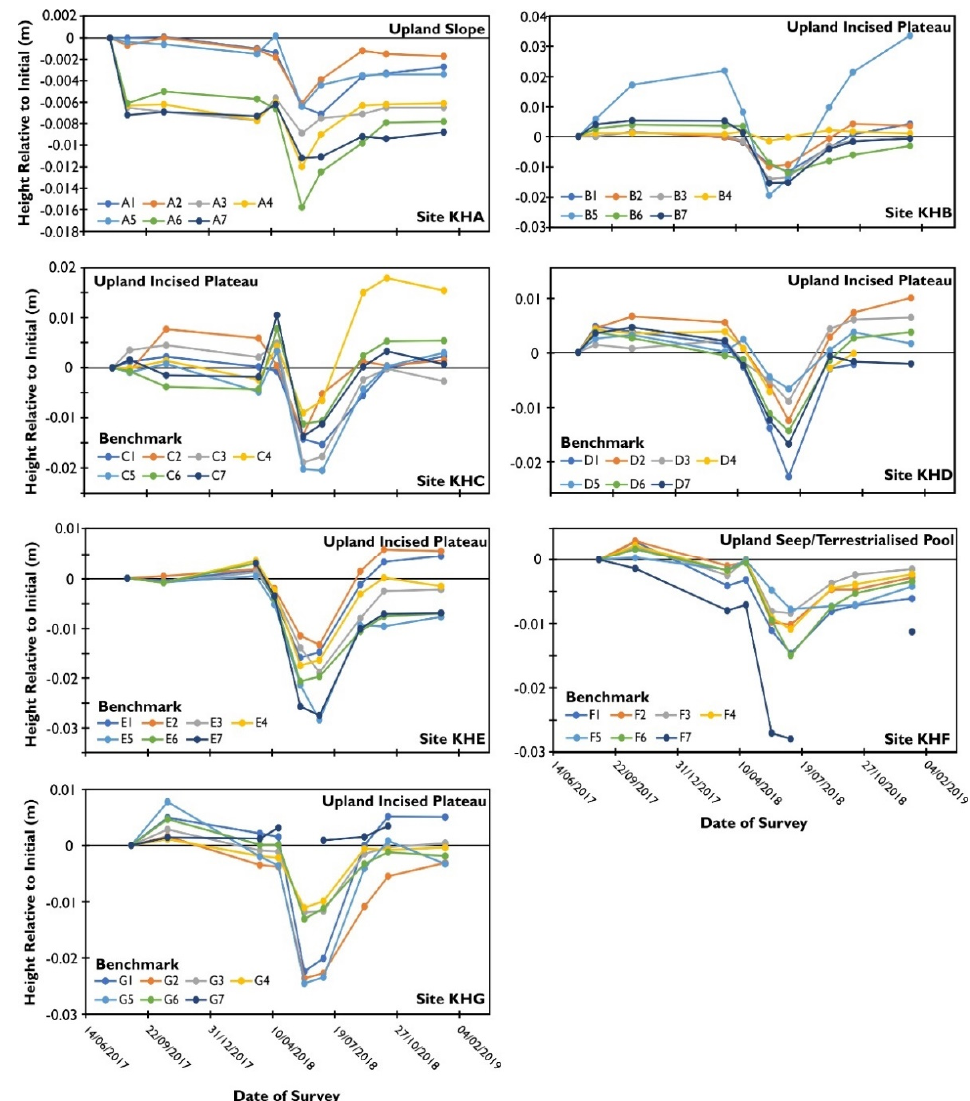
Figure A2. Precise Leveling Timeseries of individual benchmarks at subsites (Sites KH A – G ) at the Upland Knockfin Heights Site.